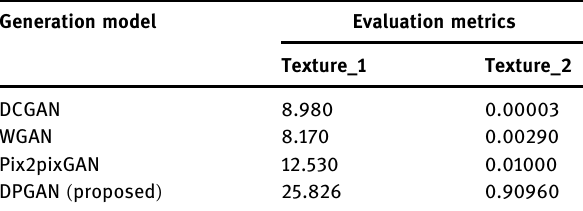
Table 1: The evaluation results of the generated fabric defect